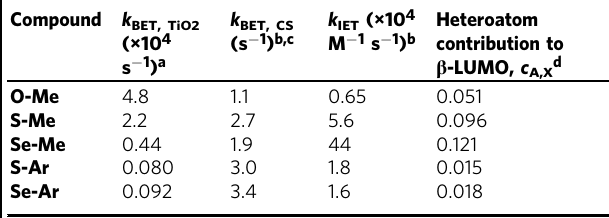
Table 2 Electron transfer kinetics and β -LUMO partition Compound k BET, TiO2 (×10